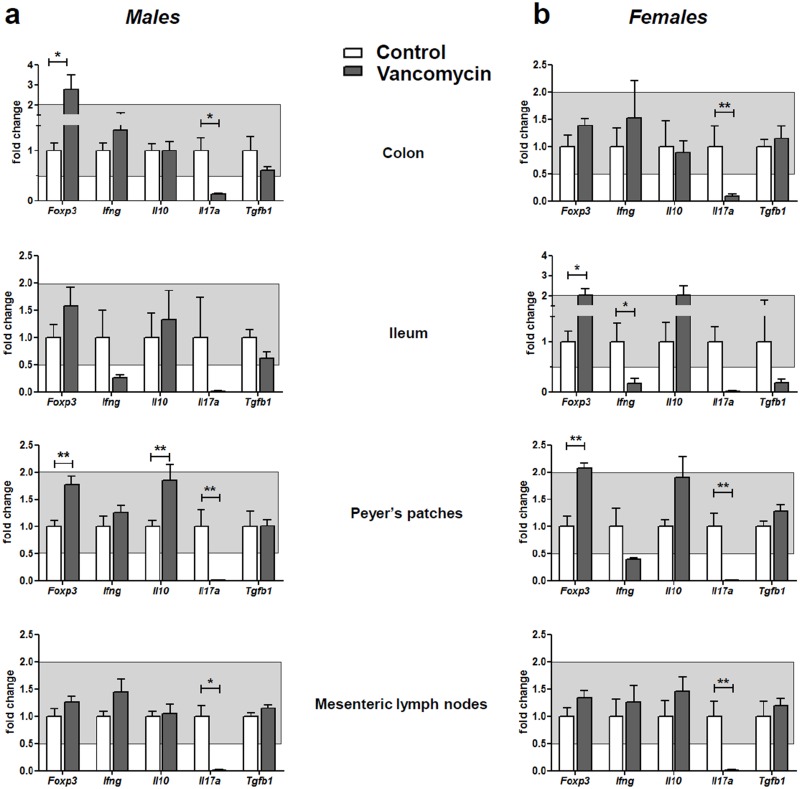
Analysis of gene expression in the gut.Relative expression of Foxp3, Ifng, Il10, Il17a and Tgfb1 in the colon, ileum, Peyer’s patches and mesenteric lymph nodes of 10-week-old male (a) and female (b) mice treated with vancomycin (grey bars) and controls (open bars). Five animals per group were analyzed. Expression of Foxp3, Ifng, Il17a and Il10 was normalized to that of Cd3, while expression of Tgfb1 was normalized to Hprt expression. Results are expressed as fold of the mean expression observed in untreated mice. Only changes in expression levels outside the grey zone indicates changes in expression >2-fold increase or decrease in vancomycin-treated mice (black bars) as compared to controls (open bars). Significant differences are indicated as follows: * p<0.05; ** p<0.01.